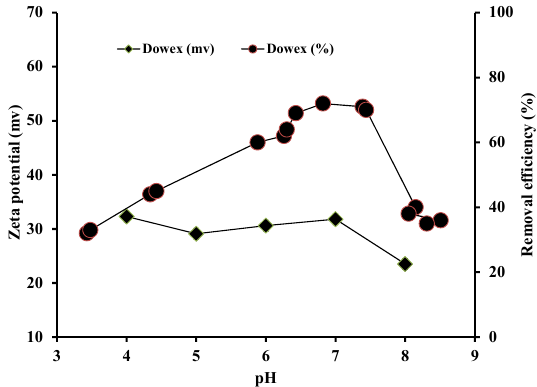
Figure 2. Effect of pH on zeta potential and phosphate removal efficiency of Dowex 21K XLT.